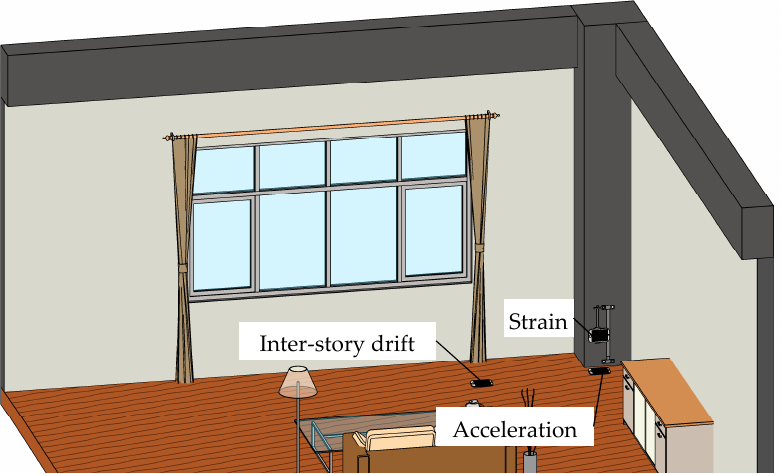
Figure 1. Arrangement of smartphones.